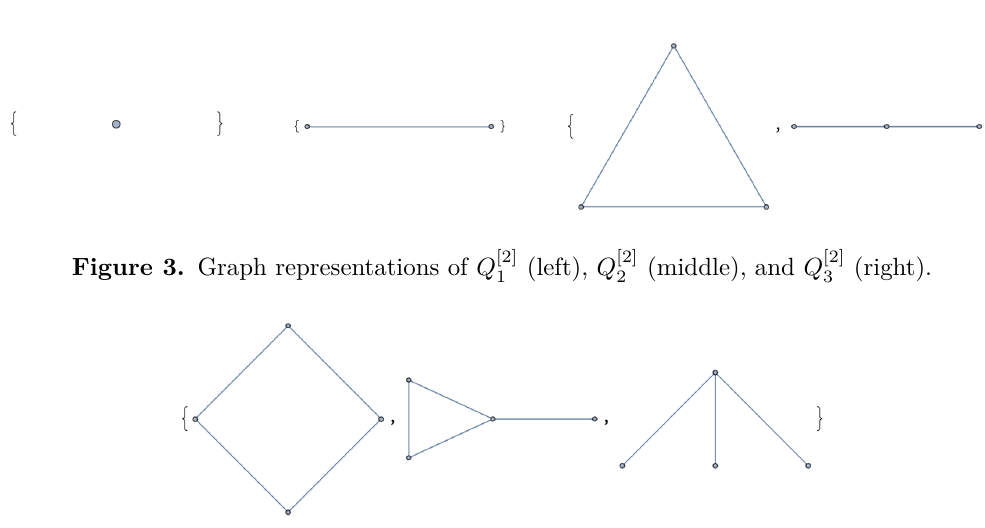
Figure 4. Graph representation of Q [2]